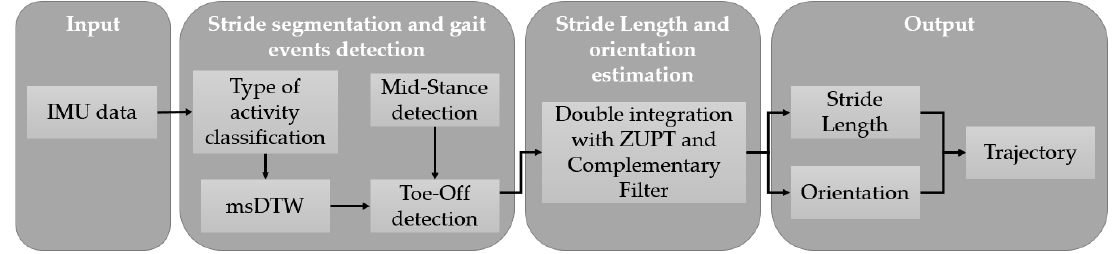
Figure 4. Pipeline for trajectory reconstruction for each activity.